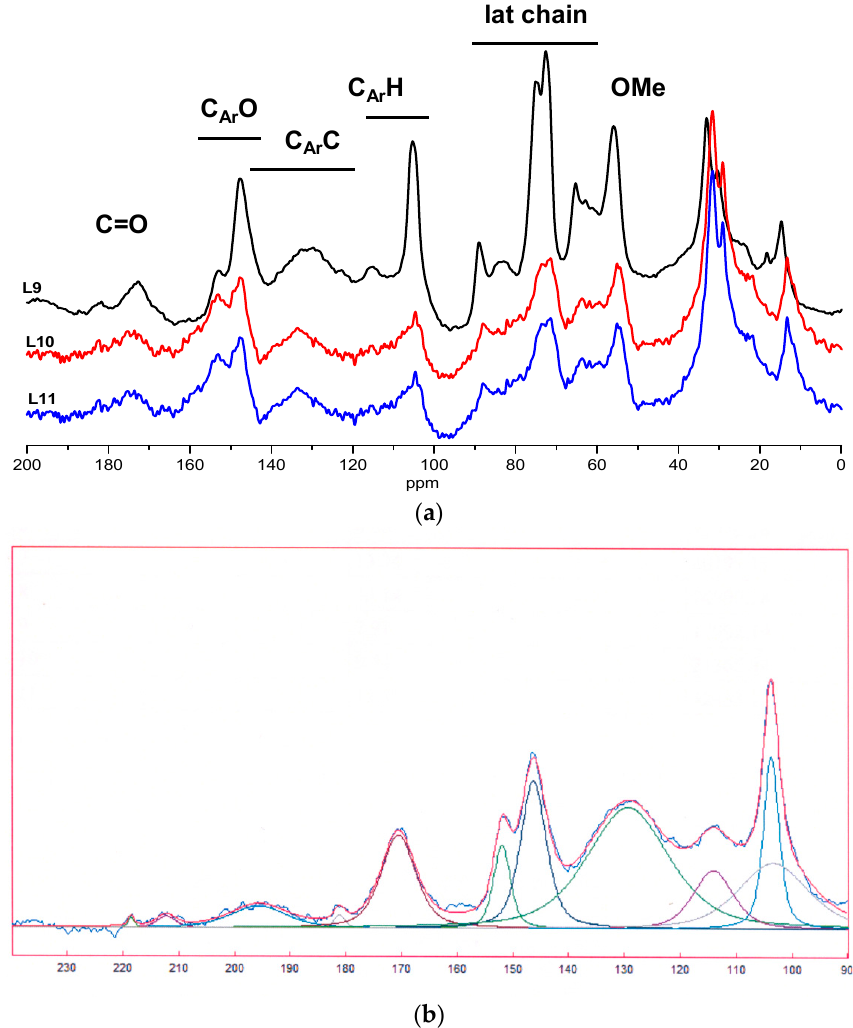
Figure 1. ( a ) Solid-state 13 C NMR spectra of L9, L10, and L11; ( b ) Example of a deconvoluted solid-state 13 C NMR spectrum (L9).